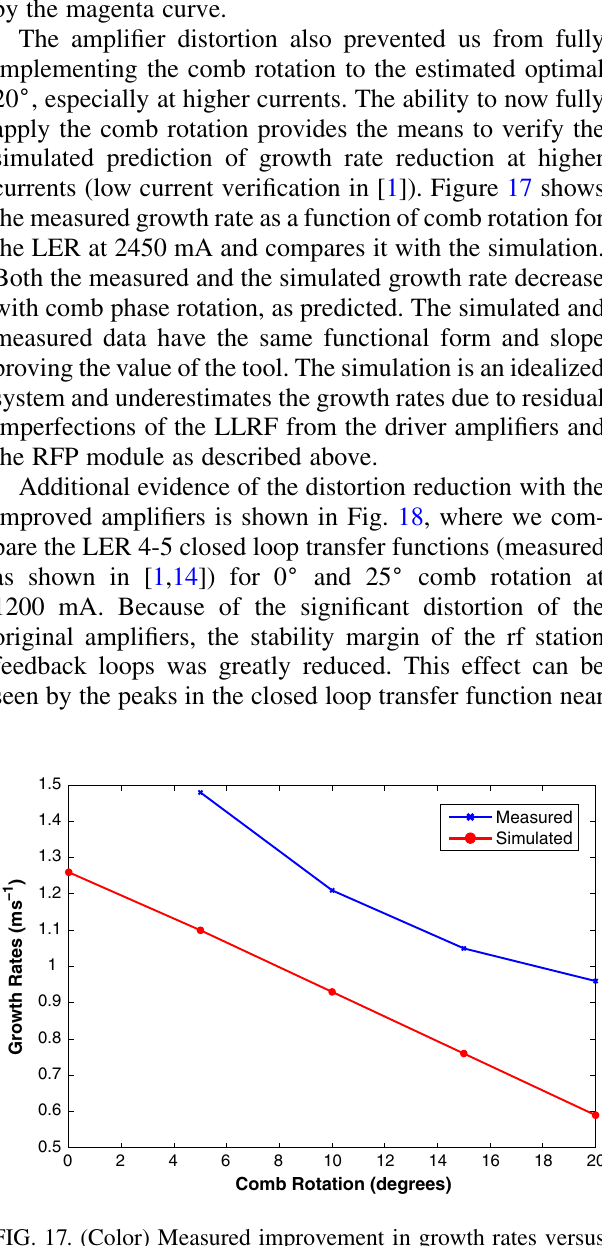
FIG. 17. (Color) Measured improvement in growth rates versus comb rotation for LER at 2450